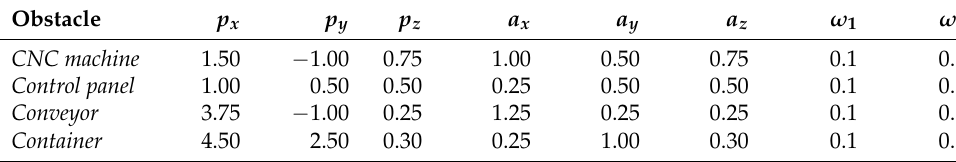
Figure 3. Mobile manipulator and the scene in the initial moment. Table 2. Parameters of the superellipsoids approximating the